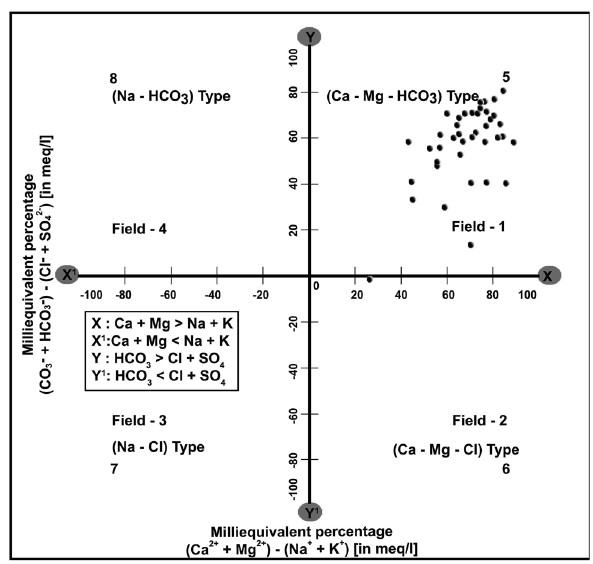
Fig. 3 Chadha’s diagram (modified piper